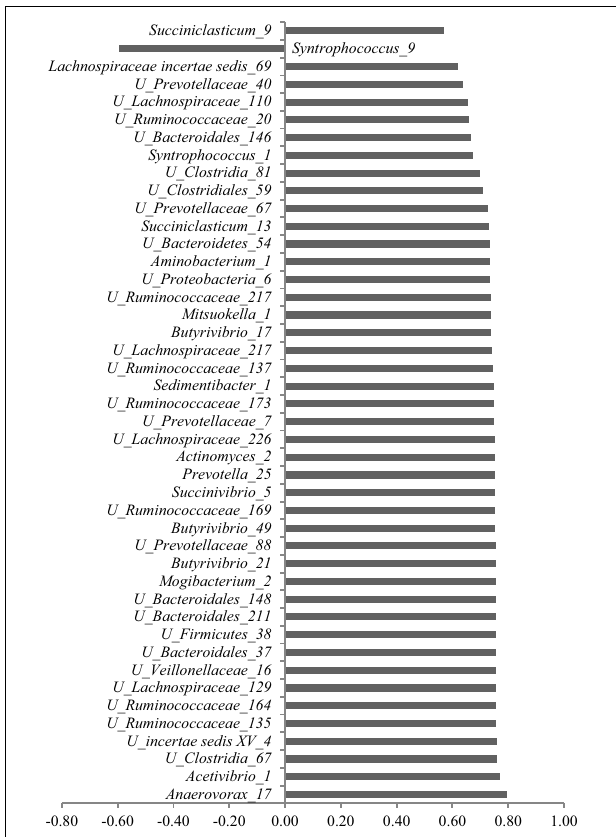
FIGURE 3 | Significant ( P ≤ 0 .05) Pearson correlation coefficients ( r ) between methane production and the relative abundances of